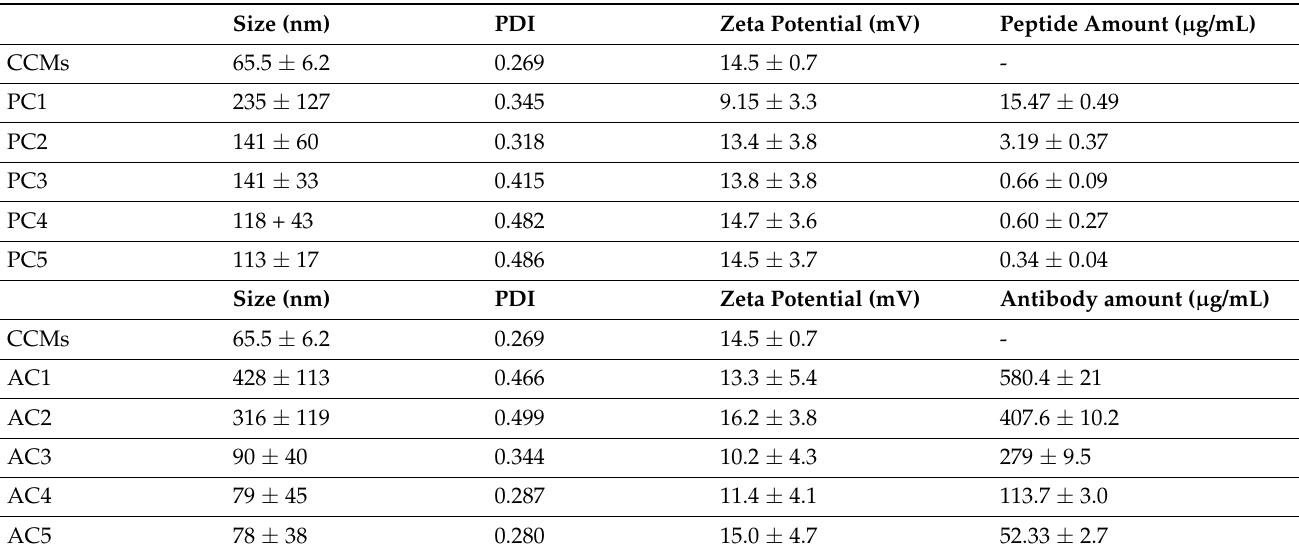
Table 1. Size, size distribution, zeta potential, peptide, and antibody amount of